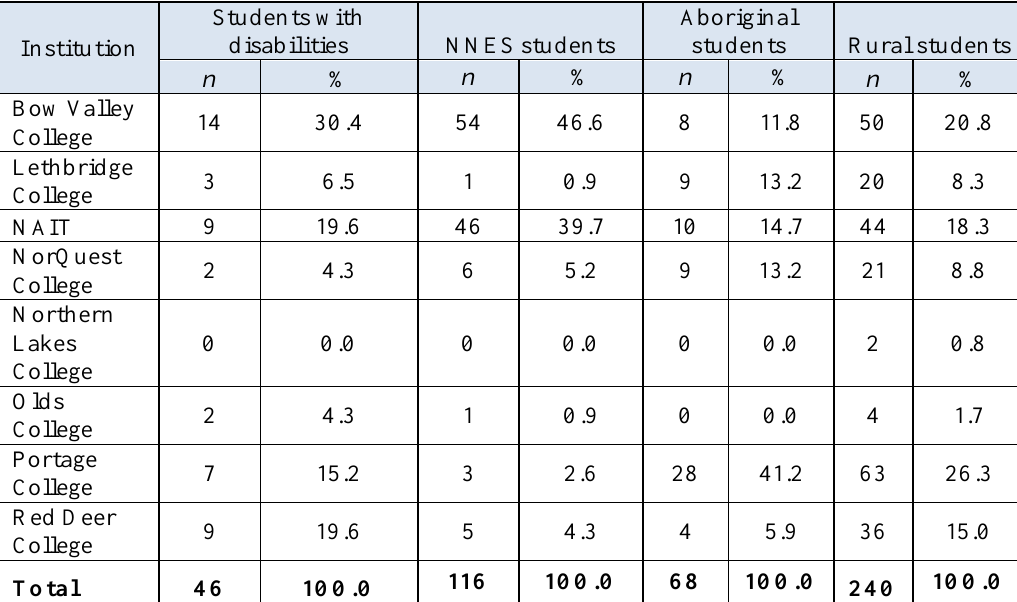
Diverse Learners by Sub-Group and